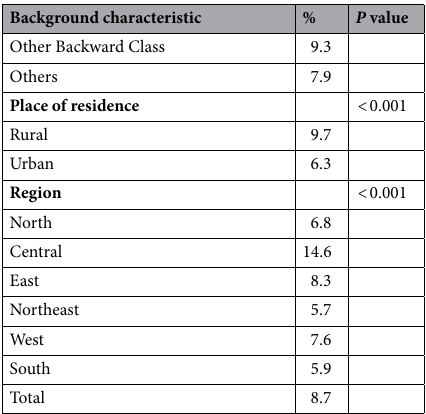
Table 2. Percentage of older adults suffering from depression by their background characteristic in India. %: Percentage; ADL: Activities of Daily Living; IADL: Instrumental Activities of Daily Living; p-value based on chi-square